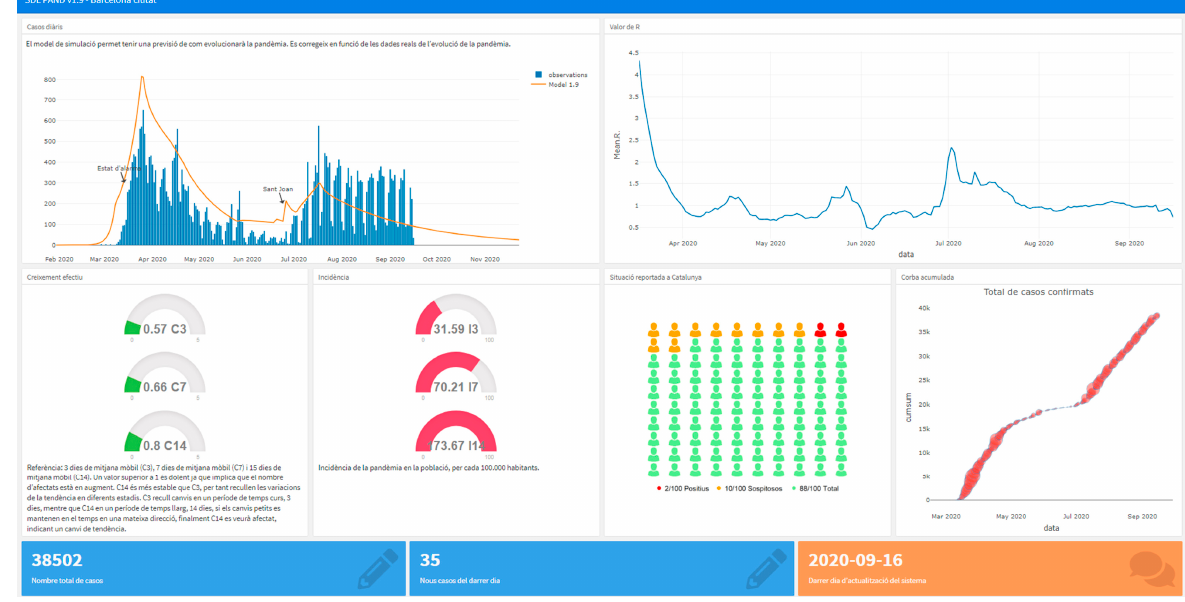
Figure 8. KPIs for Barcelona and its health area CA cells Model